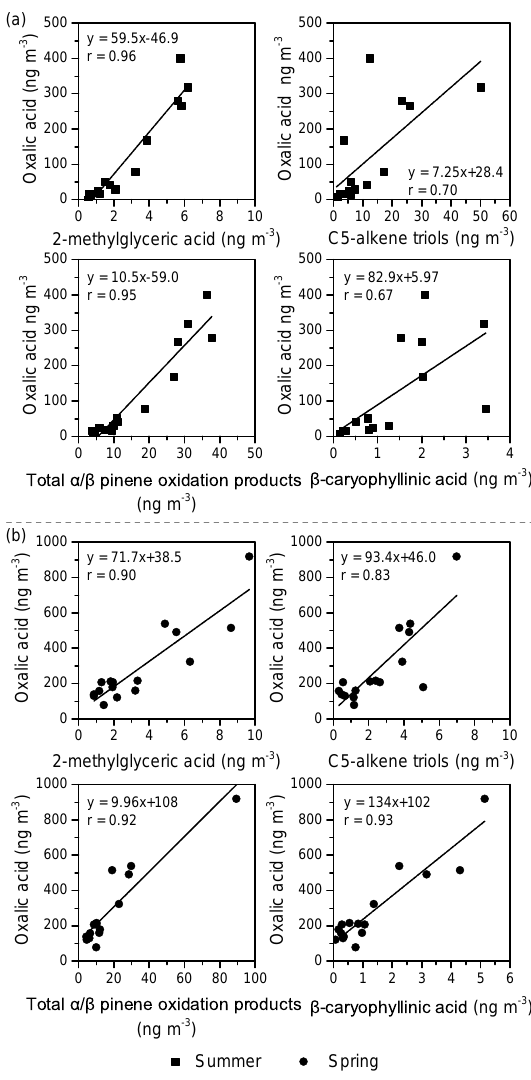
Figure 4. Linear relationship of the concentrations of oxalic acid with the detected tracer compounds for secondary organic aerosols (SOA), such as isoprene SOA tracers such as 2-methylglyceric acid and C 5 -alkene triols (sub-total of cis-2-methyl-1,3,4-trihydroxy-1- butene, 3-methyl-2,3,4-trihydroxy-1-butene, trans-2-methyl-1,3,4- trihydroxy-1-butene), α/β -pinene SOA tracers (subtotal of 3- hydroxyglutaric acid, pinonic acid, pinic acid, 3-methyl-1,2,3- butanetricarboxylic acid) and β -caryophyllene SOA tracer (i.e., β - caryophyllinic acid) from aircraft measurements over China during (a) summer and (b) spring.